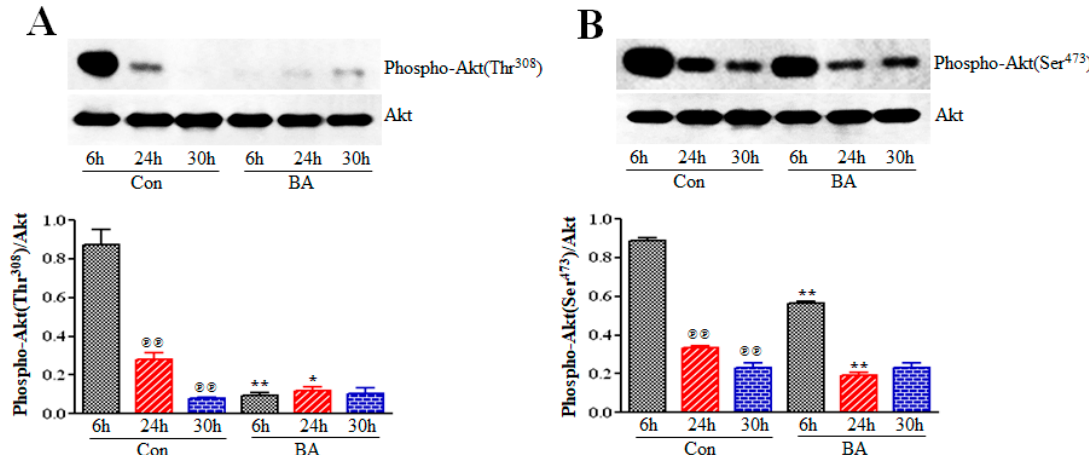
Figure 4. Inhibition of Akt activation by butyrate. VSMCs were treated with (BA) or without (Con) butyrate for indicated periods of time and then processed for western analysis of total Akt, Thr308 and Ser473 phosphorylated Akt as described in Methods Section. Total Akt levels were determined by immunoblotting with Akt-specific antibody and used as normalizing controls. Respective data are presented as mean ± S.D. ( A ) Levels of Thr308-phosphorylated Akt were determined by immunoblotting with antibody specific to phospho-Thr308Akt. ( B ) Levels of Ser473-phosphorylated Akt were assessed by immunoblotting with antibody specific to phospho-Ser473Akt. (cid:173)(cid:173) p < 0.001 vs 6 h control (Con); ** p < 0.001 vs 6 h control (Con), * p < 0.01 vs 24 h control (Con).